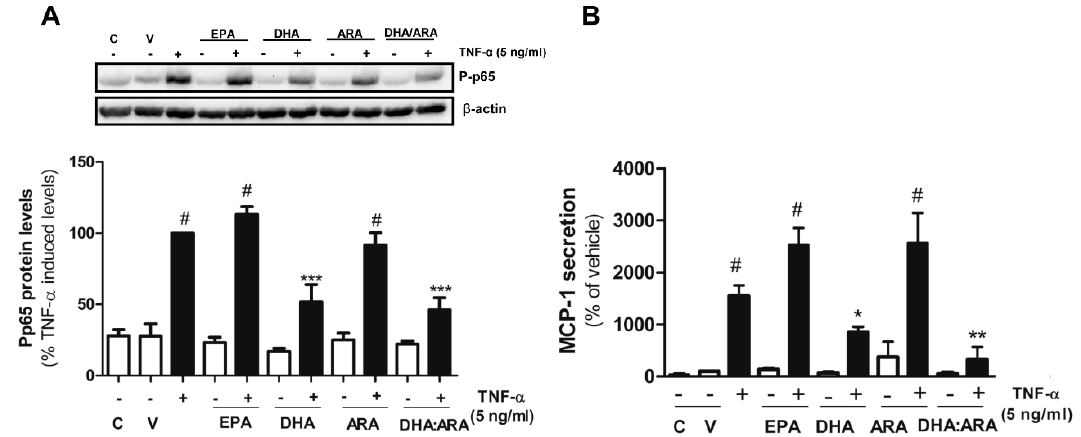
Figure 6. DHA and DHA/ARA prevent TNF- α -induced inflammation in human adipocytes. Effect of EPA, DHA, ARA (100 µM), and DHA/ARA (50 µM:100 µM) over 30 min pre-incubation on TNF- α -induced NF- κ B activation for 24 h. ( A ) Results were expressed as % of P-p65 levels induced by TNF- α . Data presented as mean ± SEM of 3–9 independent experiments; ( B ) Effect of EPA, DHA, ARA (100 µM) and DHA/ARA (50 µM:100 µM) during 30 min pre-incubation on TNF- α induced MCP-1 secretion for 24 h by the adipocytes. Results were expressed as % of MCP-1 secretion levels induced by the vehicle. Data presented as mean ± SEM of 3–6 independent experiments. # p < 0.05 vs. vehicle control; * p < 0.05; ** p < 0.01; *** p < 0.001 vs. NF- κ B activation levels induced by TNF- α . A representative blot is shown on